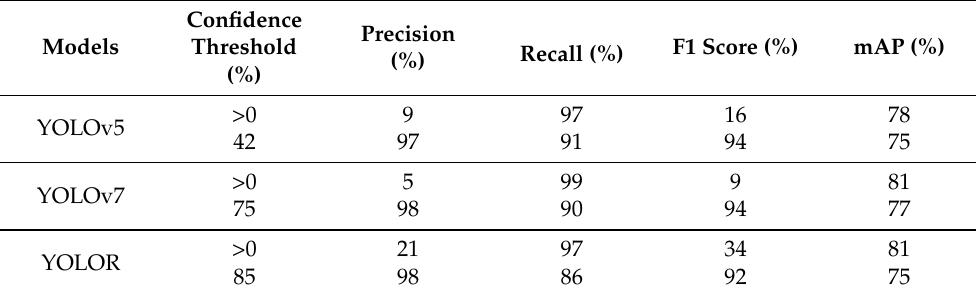
Table 7. Detection results with the test set of Grapevine Bunch Detection Dataset considering different confidence